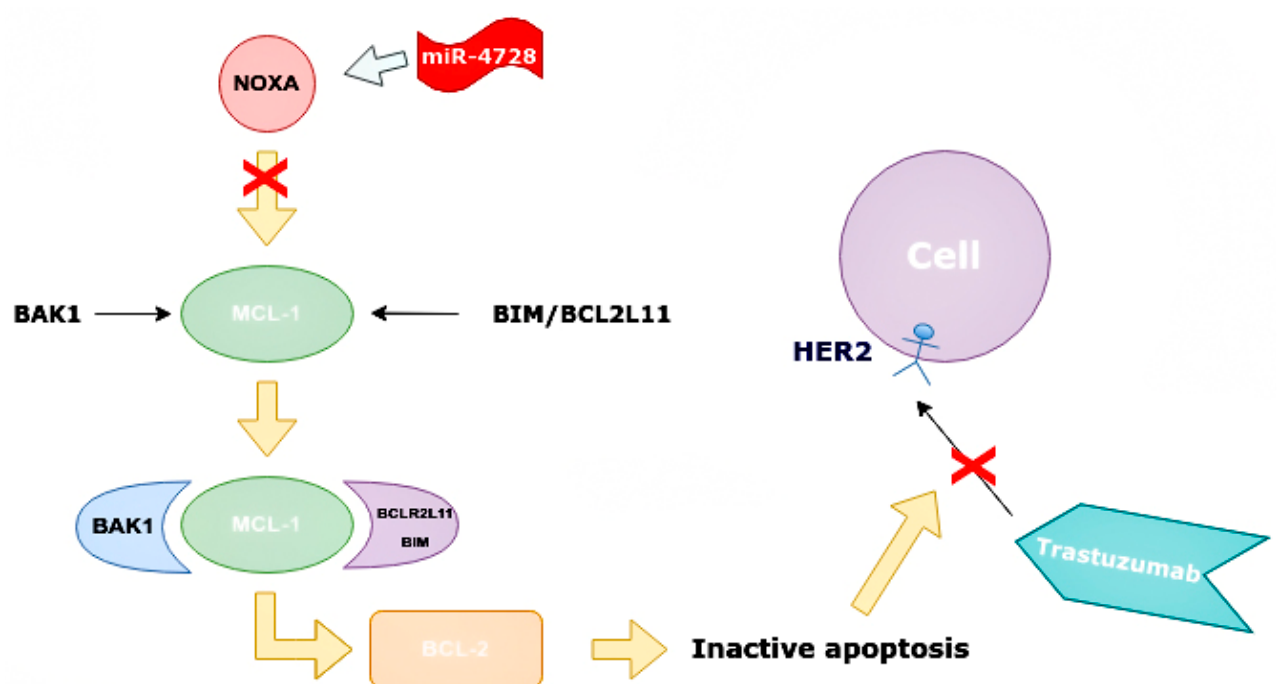
Figure 9. Suppressing effect of miR-4728 in cancer cells. MiR-4728 inhibited NOXA, thus BAK1 and BIM/BCL2L11 can combine to MCL-1. This complex inhibits BCL-2 and inactivates cell apoptosis, therefore, trastuzumab cannot impact on cells with HER2 expression. NOXA—NADPH oxidase activator, MCL-1—mantle cell lymphoma-1, BCL-2—B cell lymphoma 2 protein, BAK1—BCL-2 ho- mologous antagonist killer, HER2—human epidermal growth factor receptor 2, BIM/BCL2L11—Bcl-2 interacting mediator of cell death (commonly called Bcl ‐ 2 ‐ like protein 11).